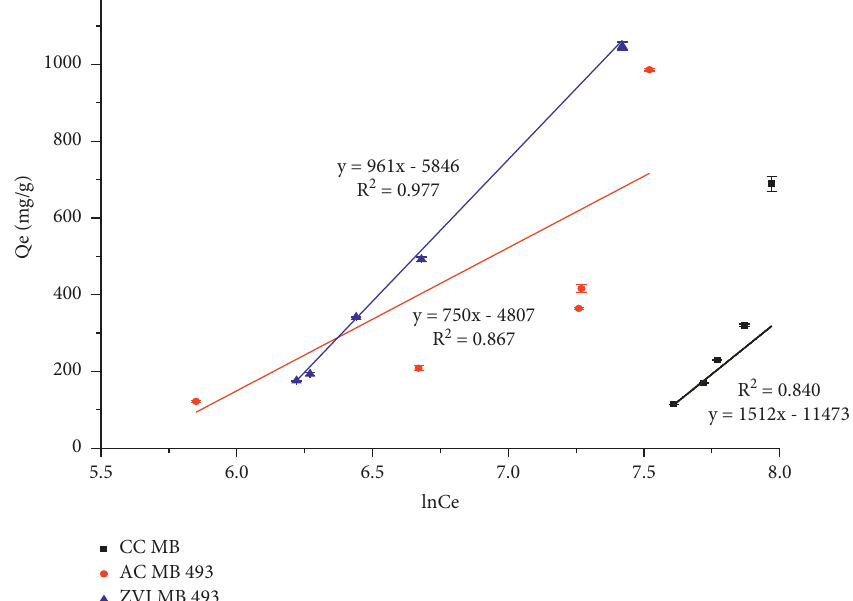
Figure 11: Temkin adsorption isotherm for removal of β -carotene onto CC MB, AC MB 493, and ZVI MB 493 at 95 °